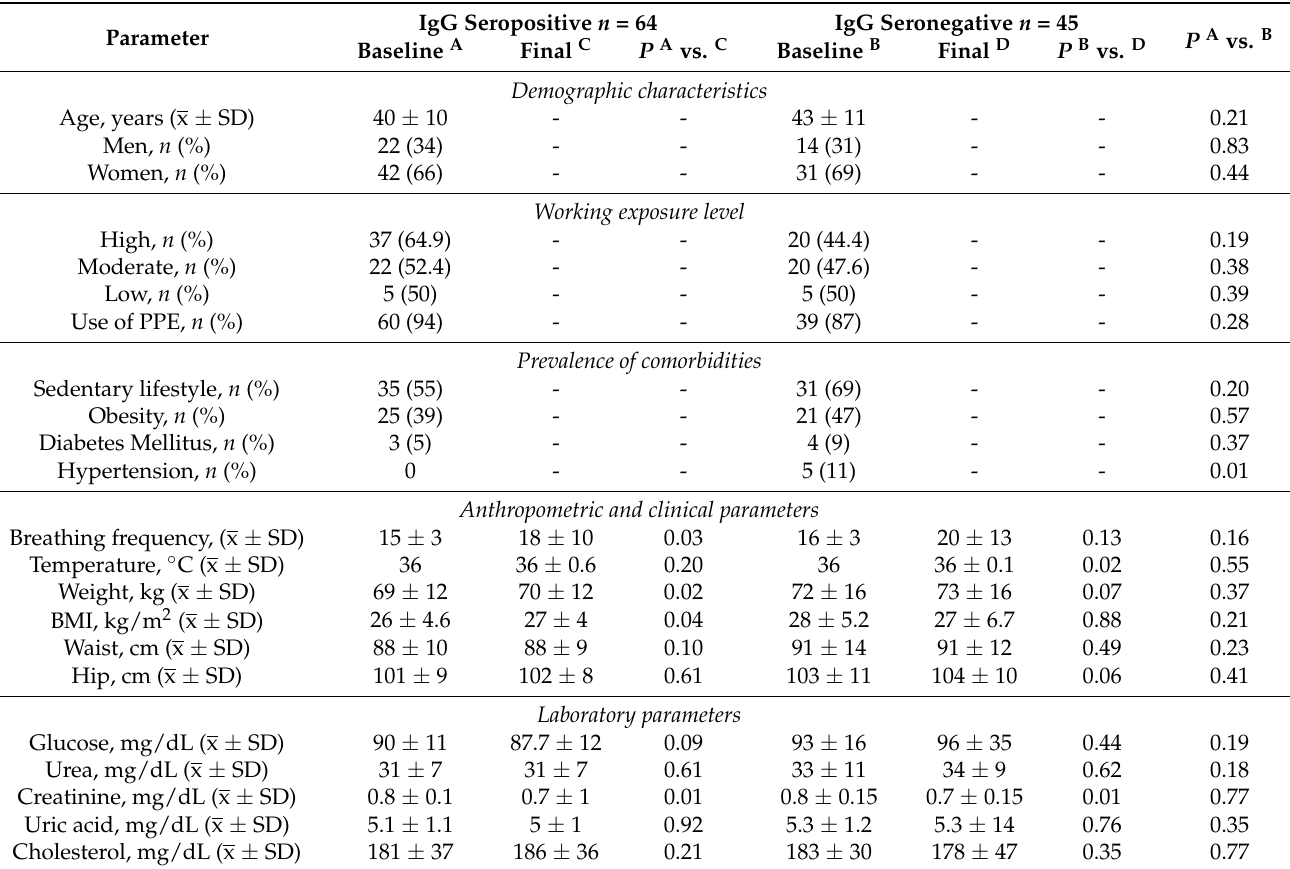
Table 1. Demographic, anthropometric, clinical, laboratory, and working characteristics of